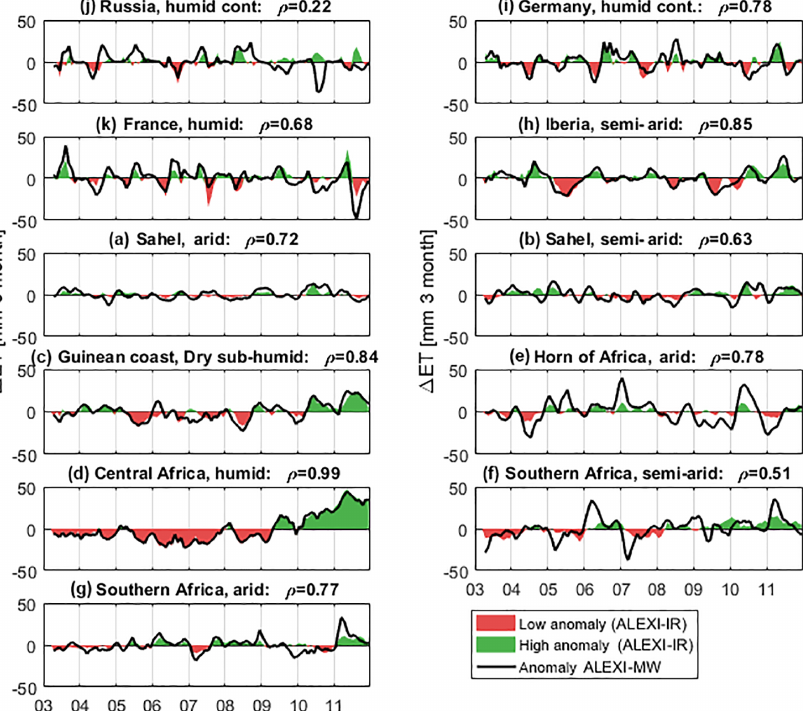
Figure 7. Comparison of anomaly in 3-month ET totals as calculated from ALEXI-IR and ALEXI-MW for selected regions (see Fig. 3 for definition of regions).